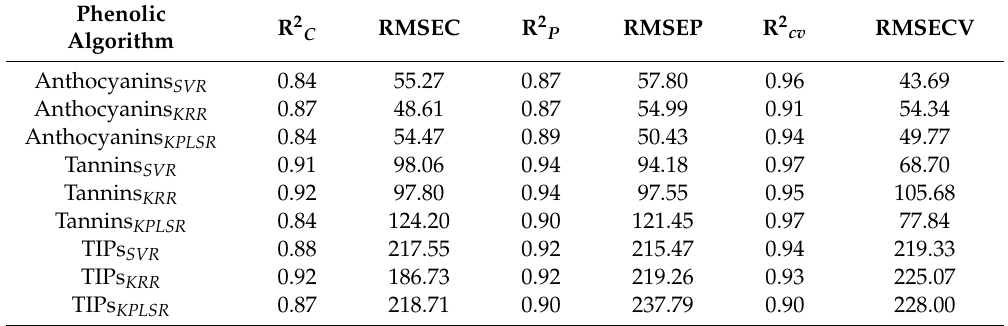
Table 1. Comparison of the predictive performance of support vector regression (SVR), kernel ridge regression (KRR), and kernel partial least squares regression (KPLSR) for the prediction of anthocyanins, tannins, and total iron reactive phenolics (TIPs) in red wine. RMSEC is the root mean squared error of calibration, RMSEP is the root mean squared error of prediction, and RMSECV is the root mean squared error of cross-validation. R 2 C gives R 2 values for calibration, R 2 P gives R 2 values after for prediction, and R 2 CV gives R 2 values for